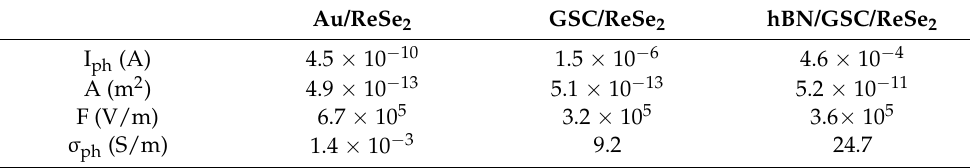
Figure 8. ( a ) Schematic side-view and ( b ) optical top-view image of the GSC/ReSe 2 device with the hBN passivation layer. ( c ) Raman spectra representative of hBN (black line), graphene (red line), and ReSe 2 (blue line). ( d ) Time response under illumination at V bias = 50 V and ( e ) rise/decay time plot. ( f ) Photoresponse decay was performed at three increasing bias voltages: V bias = 50, 80, 100 V. V a is the second scan, obtained immediately after the first scan. Table 1. Photodetector characteristics tested under white light